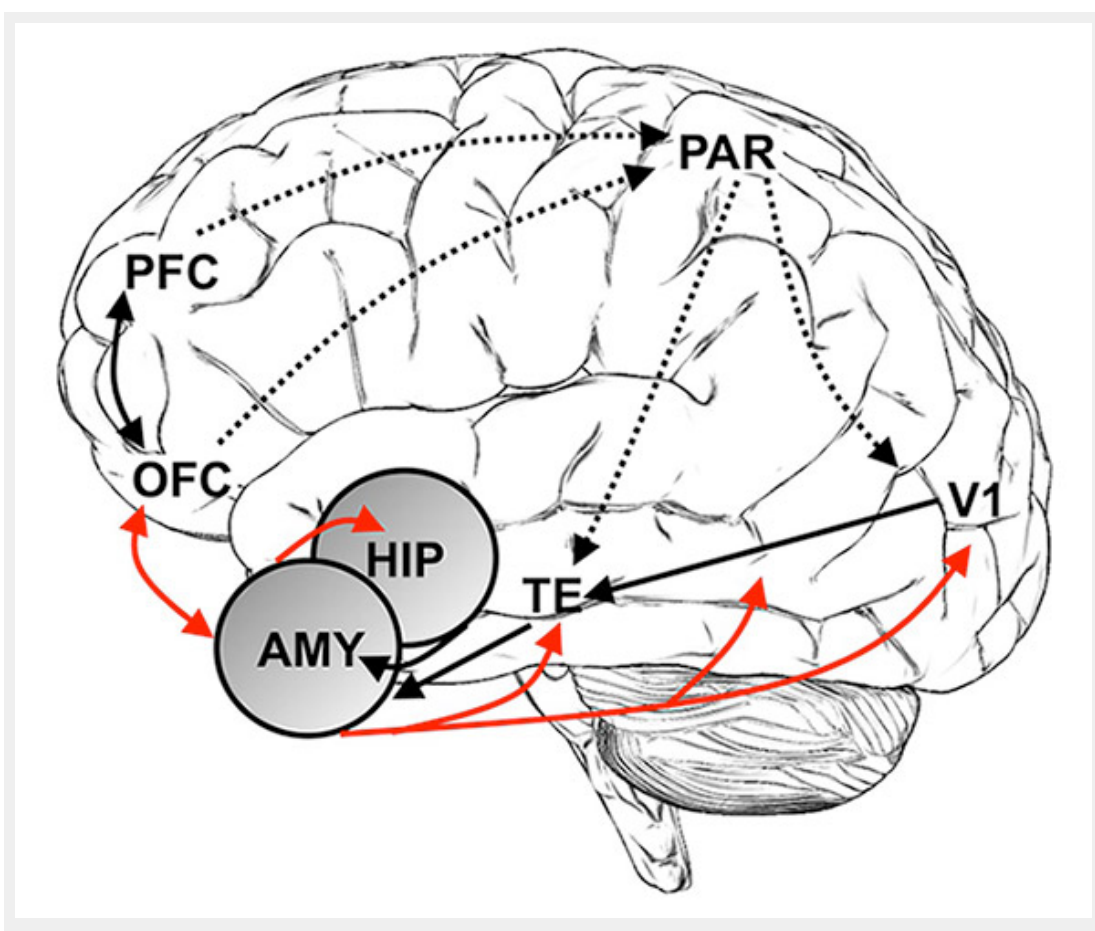
Figure 2 Schematic illustration of brain areas involved in selected cognition-emotion interactions. The amygdala (AMY) has widespread reciprocal connections with many cortical regions, including perceptual pathways (primary visual cortex, V1, inferior temporal cortex, TE), memory-related regions (hippocampus, HIP), and prefrontal regions (orbitofrontal cortex, OFC, prefrontal cortex, PFC). This connectivity enables the amygdala to receive rich sensory information and to strengthen the neural representation of emotional stimuli via feedback to sensory pathways, attention- related regions (PFC and parietal lobe, PAR), and memory regions. In addition, multiple connections to prefrontal areas relay amygdala input to regions involved in more deliberate forms of decision-making and allow for modulations of amygdala activity based on more complex motivational contingencies. Thus, following amygdala activation, multiple brain systems can dynamically reorganise to appropriately deal with the current